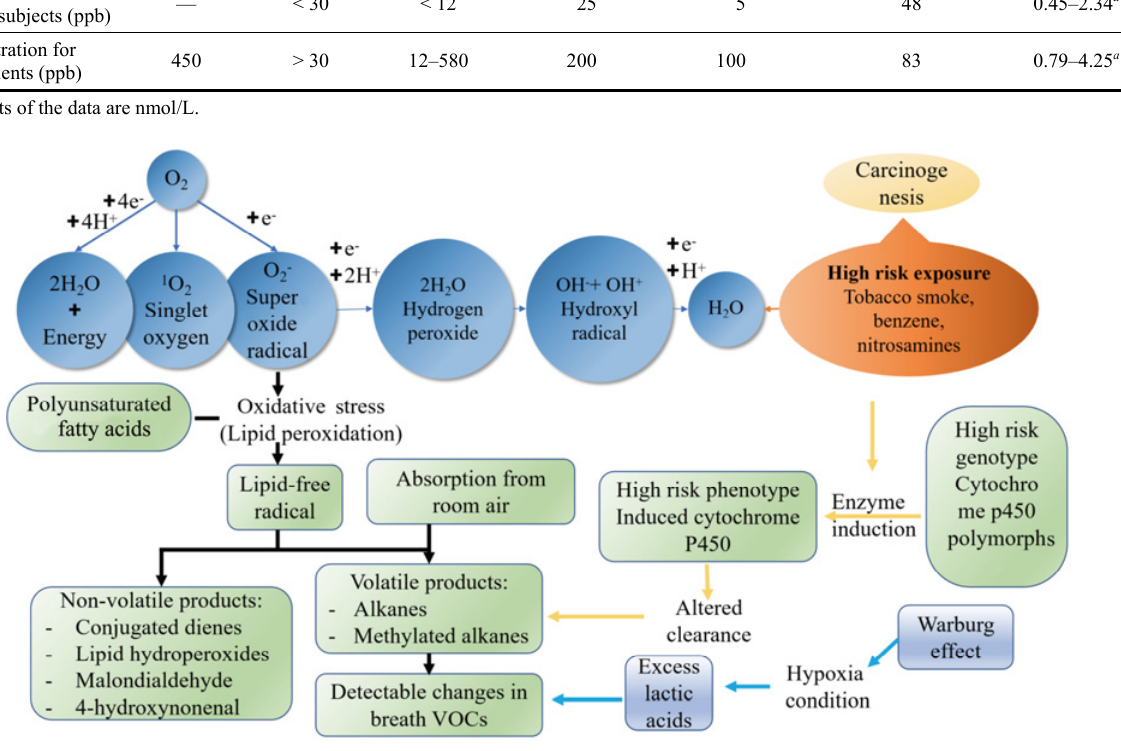
Fig. 1 Hypothetical basis of breath analysis technology for the detection of early